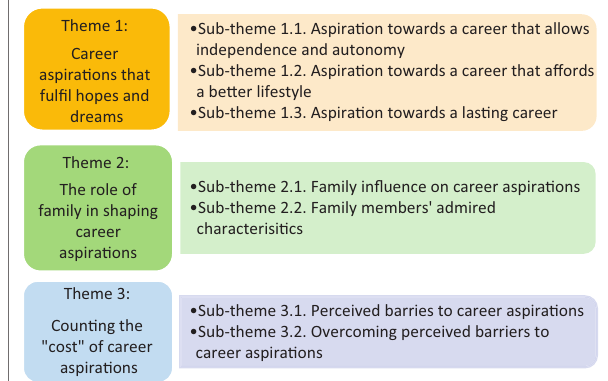
FIGURE 4: Main and sub-themes that emerged from the analysis of the different forms of